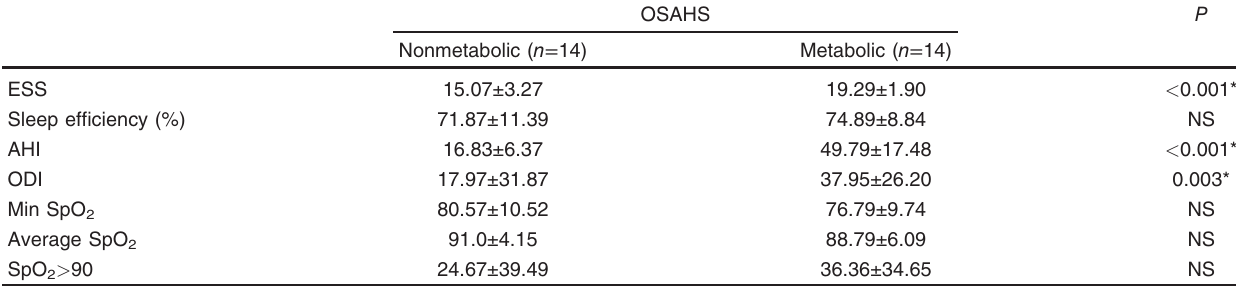
Table 3 Comparison between the two studied groups according to respiratory sleep parameters and Epworth sleepiness scale